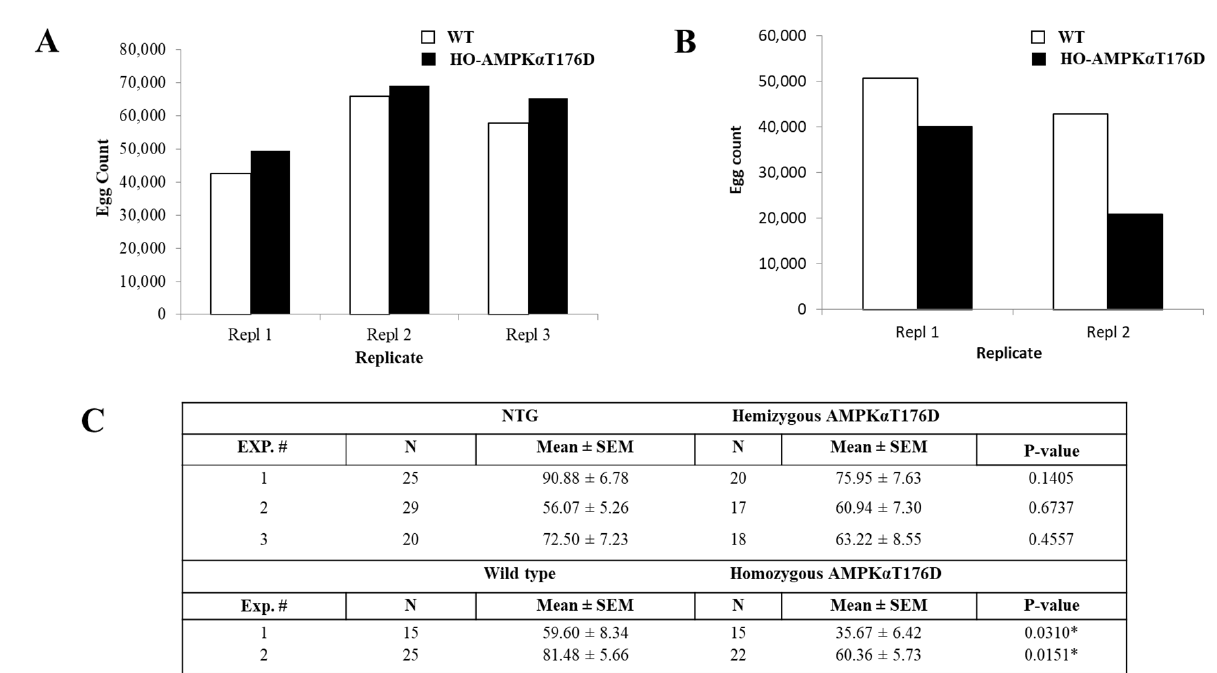
Figure 6. Impact of HA-AMPK α T176D overexpression on lifetime fecundity. Graphs represent total egg production of hemizygous ( A ) and homozygous ( B ) TG females compared with NTG or wild type control females, respectively, throughout their lifespans. No significant differences were observed between hemizygous TG and NTG or homozygous TG and wild type females ( p > 0.05). ( C ) Egg counts for TG and wild type female mosquitoes. Results are presented for each replicate separately, including the number of females tested (N), the mean number of eggs laid ± SEMs, and p -values by Wilcoxon